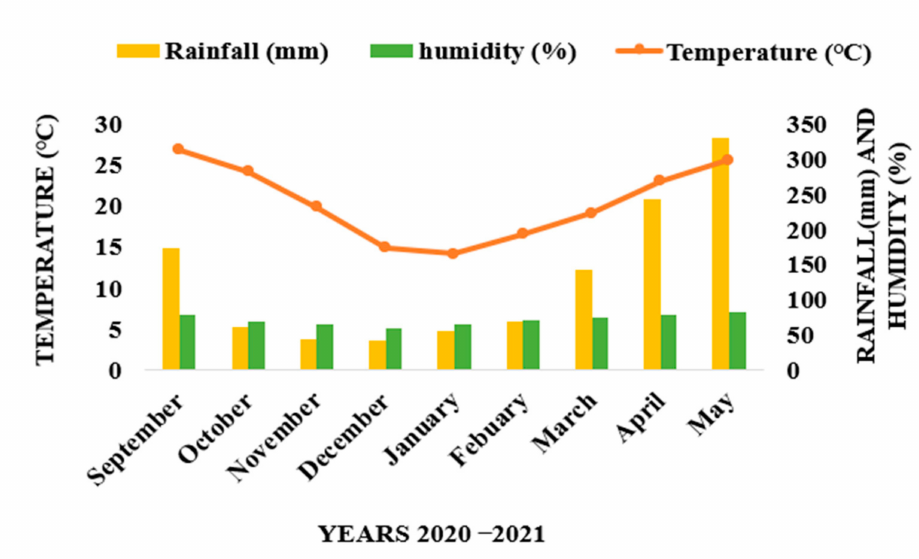
Figure 2. Meteorological data from the experimental site; data used are the